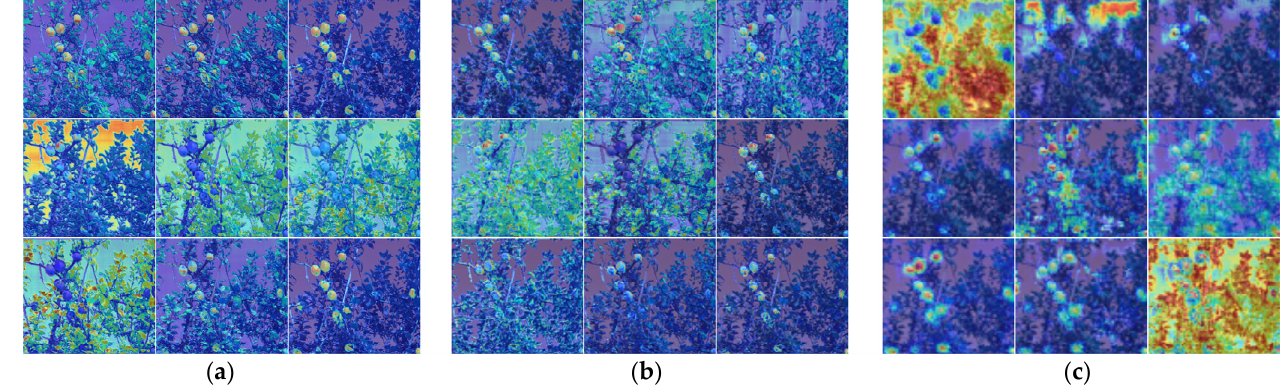
Figure 7. Backbone feature extraction network feature map. ( a ) CA output 80 × 80 characteristic figure. ( b ) CA output 40 × 40 characteristic figure. ( c ) SPPF output 20 × 20 characteristic figure.